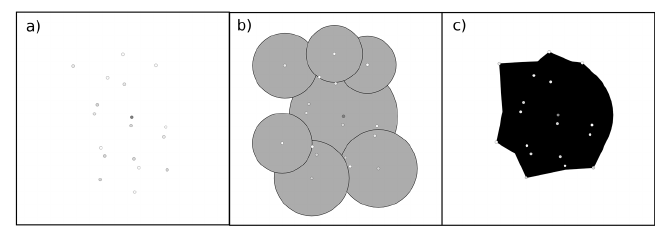
Figure 3. Graphical representation of steps in the segmentation procedure: ( a ) Laser echoes viewed from above, darker color indicates echoes higher above ground; ( b ) Each echo is associated with a circular segment. Note that the segment of the echo highest above ground is created first, and echoes inside this segment are treated as reflected from this segment; ( c ) Overlapping circular segments are merged based on the degree of overlap (see text for details), with the echoes of the smaller segments added as vert ices in the larger segment, forming the final segment (shown in black).